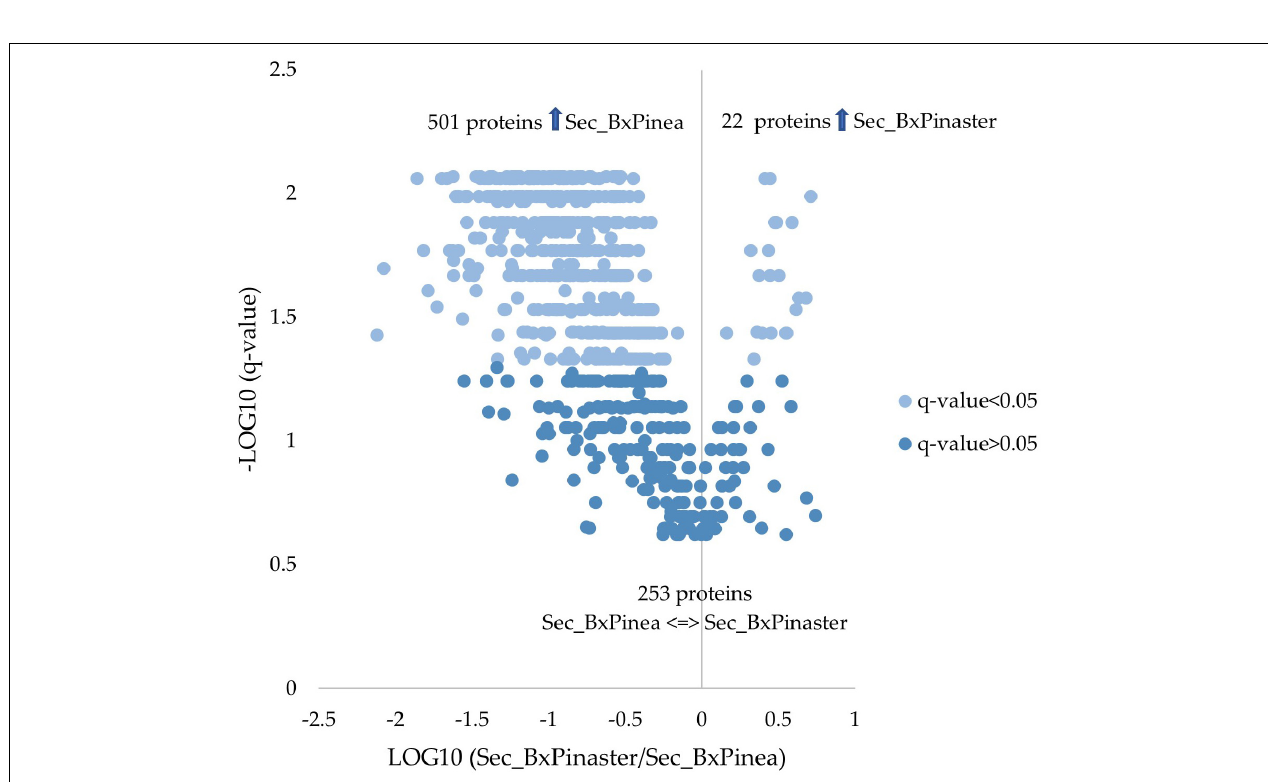
FIGURE 1 | Bursaphelenchus xylophilus secretome profile. Distribution of 776 secreted proteins according to gene ontology (GO) terms: molecular function (blue), biological process (green), and cellular component (gray).